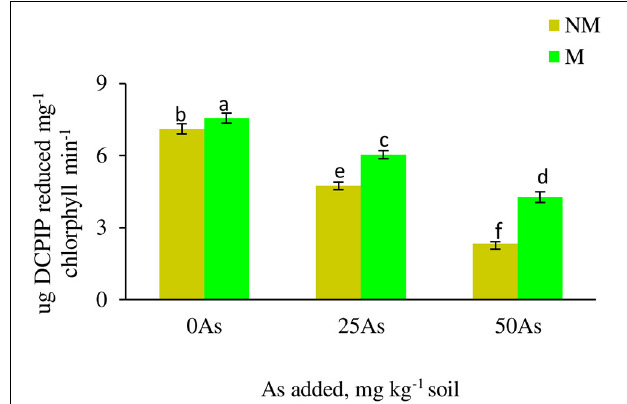
FIGURE 1 | Hill reaction activity in leaves of Triticum aestivum in response to Rhizophagus intraradices inoculation (M, mycorrhizal; NM, non-mycorrhizal) and As addition to the soil. Values represent means of three biological replicates ± SD. Different letters represent significant difference at p ≤ 0.05 , derived from Tukey’s honestly significant difference (HSD). 0As, 0 mg As kg − 1 soil treatment; 25As, 25 mg As kg − 1 soil treatment; 50As, 50 mg As kg − 1 soil